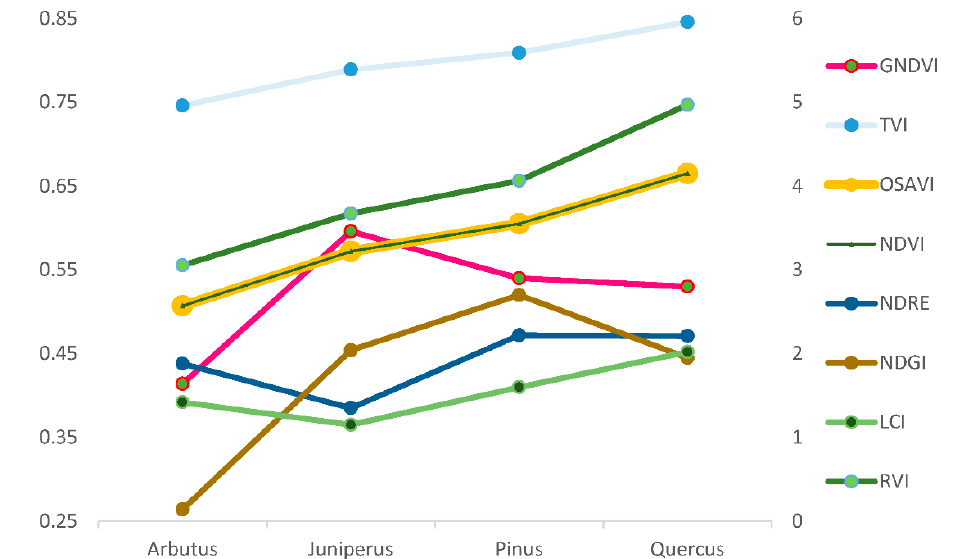
Figure 9. Comparison of the vegetation indices per genus in Mesa del Pawiranachi, NDVI = normalized difference vegetation index, GNDVI = green NDVI, LCI = leaf chlorophyll index, NDRE = normalized difference red edge index, OSAVI = optimized soil adjusted vegetation index, RVI = ratio vegetation index, TVI = transformed vegetation index, NDGI = normalized difference greenness index.